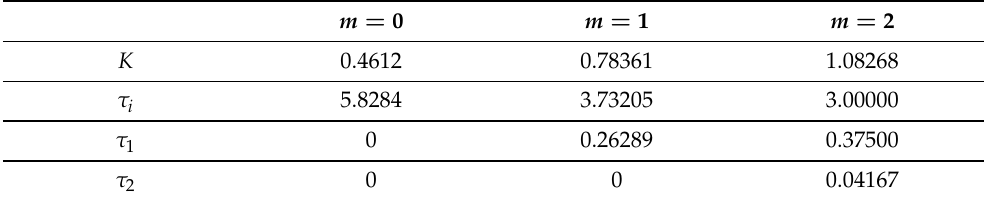
Table 1. Optimal PID m parameters corresponding to (5) and (7), m ∈ [ 0,2 ] .